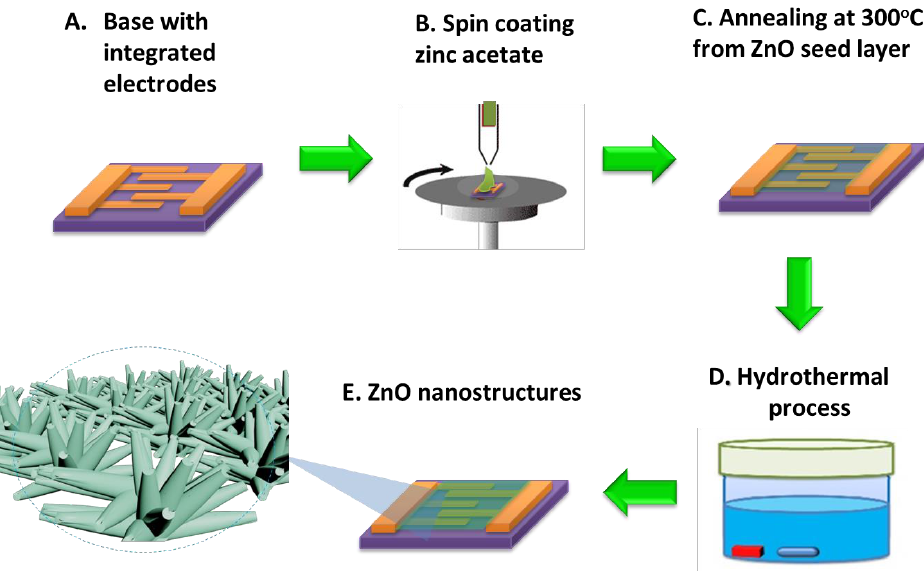
Figure 1. Synthesis of ZnO nanostructures on integrated electrodes.